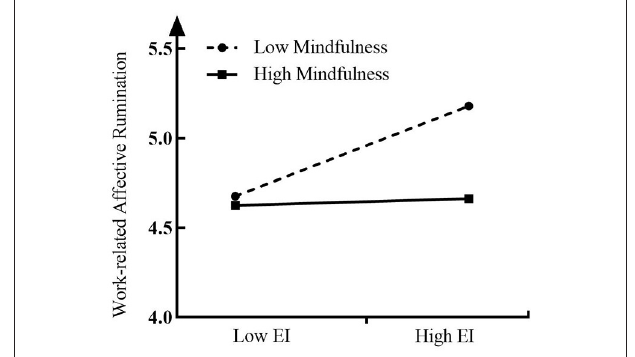
FIGURE 2 | Interactive effect of the entrepreneurial identity and entrepreneurial mindfulness on work-related affective